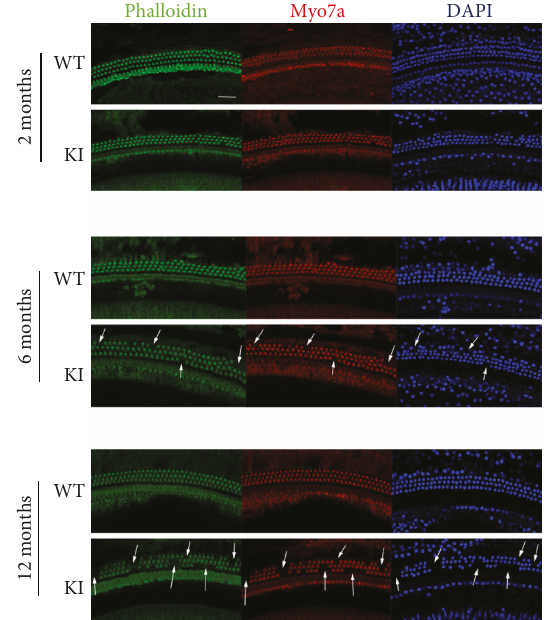
Figure 3: The degeneration of stereocilia and the hair cell loss in the Myo3a mutant mice showed by confocal images. Confocal images of the stereocilia, hair cells, and nucleus in Myo3a mutant and WT mice at two months old, six months old, and 12 months old. Images were taken from the middle turn of the cochlea. Scale bar =20 μ m. The stereocilium degeneration and the loss of hair cells can be seen in the Myo3a mutant mice from 6 months old, and this phenomenon becomes more serious in 12-month-old Myo3a mutant